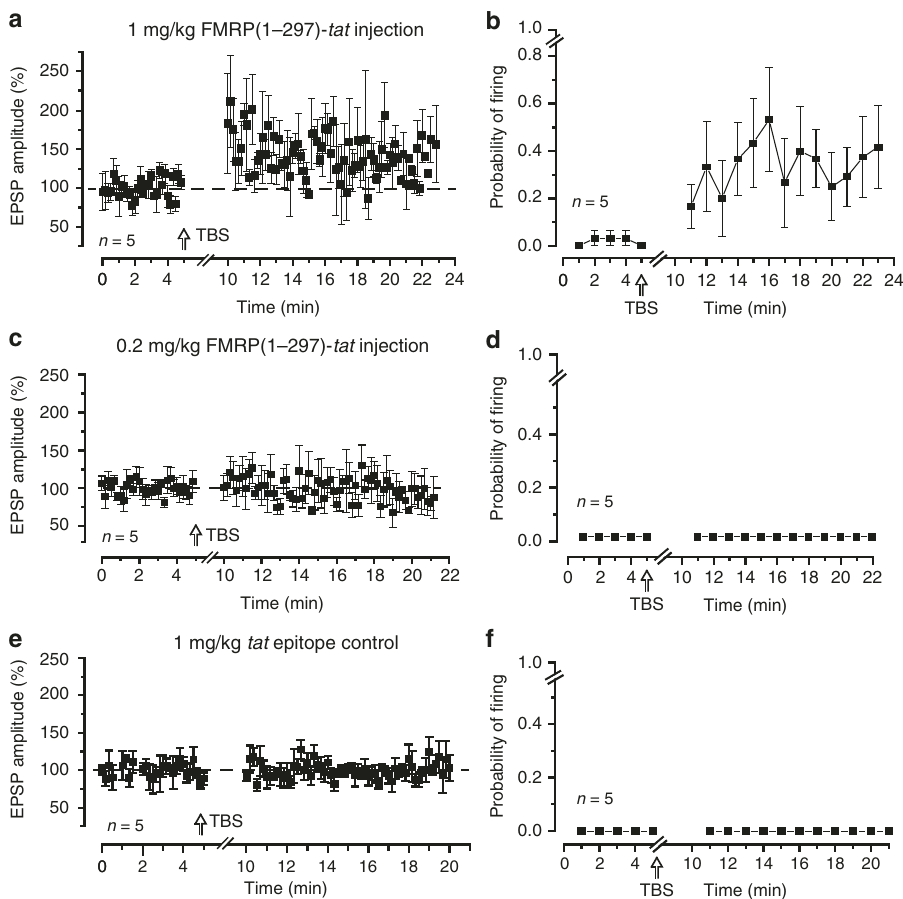
Fig. 7 FMRP(1 – 297)- tat restores LTP at the mossy fi ber-granule cell synapse of Fmr1 KO mice. Shown are plots of mossy fi ber-evoked EPSP amplitude and spike fi ring probability measured in granule cells from Fmr1 KO mice in slices prepared 2 h following tail vein injections. EPSP amplitudes were calculated only for stimuli that were subthreshold to spike discharge. LTP in response to TBS of mossy fi bers is restored to near WT levels by prior injection of 1.0 mg/kg FMRP(1 – 297)- tat in terms of EPSP amplitude ( a ) (% change in EPSP: 141.0 ± 23.2%, n = 5 cells from 5 mice), fi ring probability ( b ) (resting condition 2.0 ± 2.2%, after TBS 36.8 ± 18.4%, n = 5 cells from 5 mice), but with no effect following 0.2 mg/kg FMRP(1 – 297)- tat injection ( c , d ) (% change in EPSP: 99.6 ± 10.9%, n = 5 cells from 5 mice) or injection of the tat epitope alone ( e , d ) (% change in EPSP: 100.4 ± 1.2%, n = 5 cells from 4 mice; no spikes fi red in resting condition or after TBS was delivered). Average values are mean ± s.e.m. Source data are provided as a Source Data fi